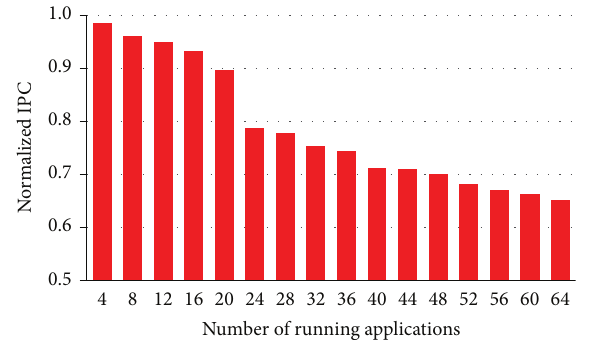
Figure 1: Performance decay of h264ref due to NoC contention (experimental setup is in Section 4).